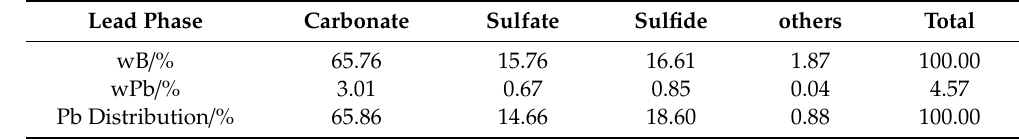
Table 4. Analysis results of lead phase.